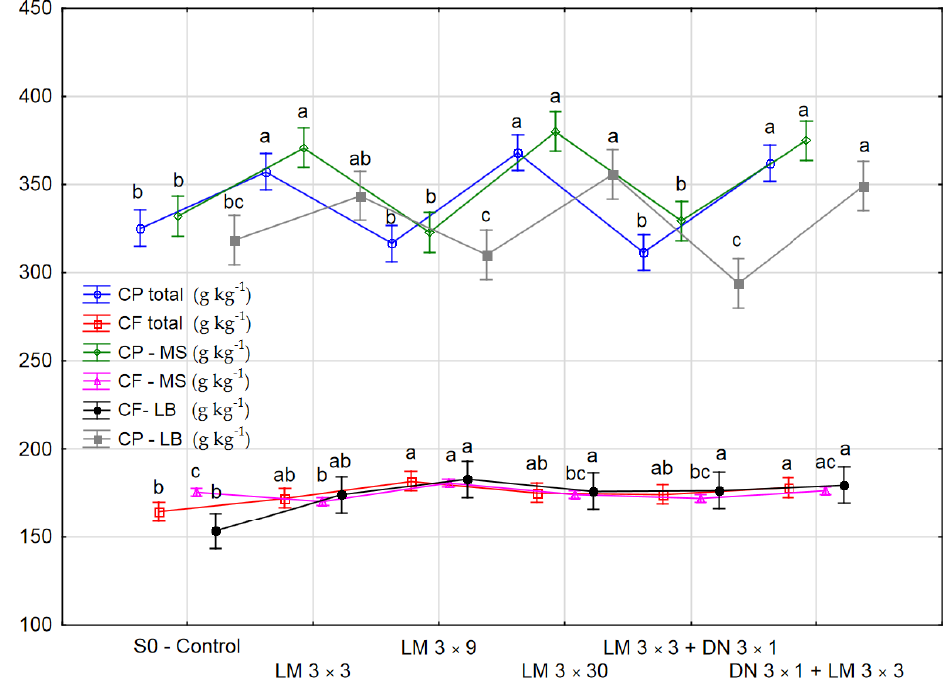
Figure 2. Selected quality traits of grain obtained from shoots (main versus lateral), depending on the type of seed stimulation. Crude protein (g kg −1 ), average from plant (CP-Total); crude fat (g kg −1 ), average from plant (CF-Total); crude protein (g kg −1 ), main shoot (CP-MS); crude fat (g kg −1 ), main shoot (CP-MS); crude fat (g kg −1 ) , lateral branches (CF-LB); crude protein (g kg −1 ), lateral branches (CP-LB). Means in columns with different letters are significantly different ( p < 0.05).